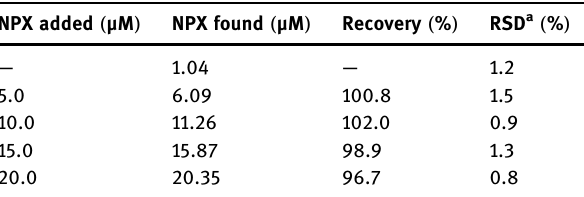
Table 3: Detection of NPX in pharmaceutical tablets by standard addition method